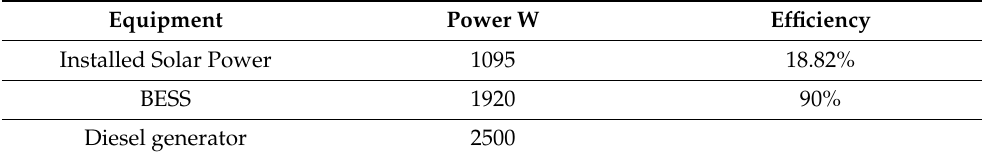
Table 3. Technical power generation